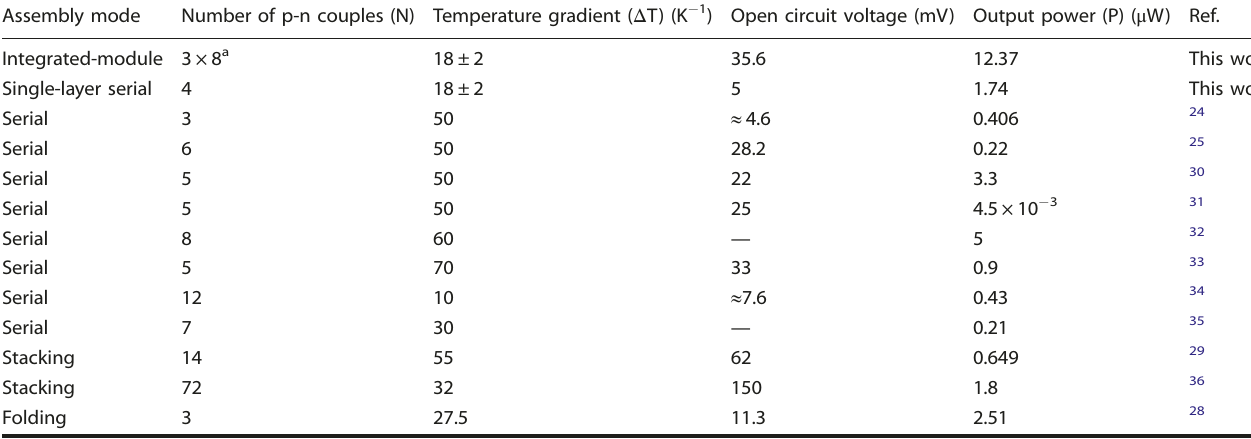
Table 1. A summary of TE properties of the versatile fl exible devices, including the present work and some representative examples in previous